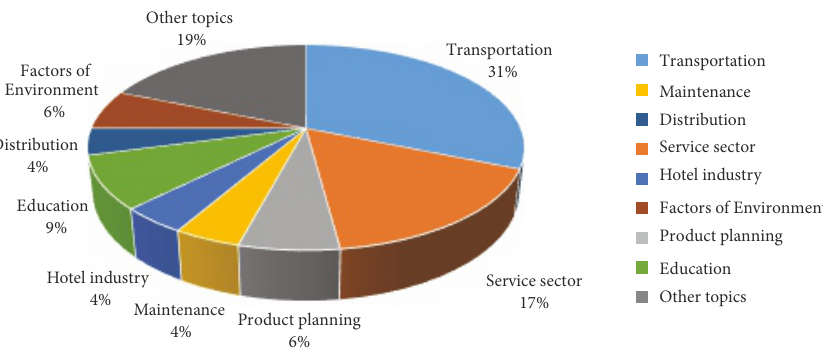
Figure 6. Percent of the prominent DEA application area in